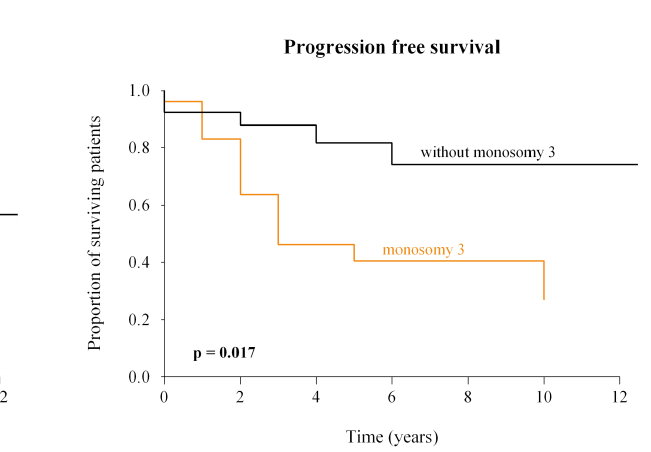
Fig. 1. Progression free survival (until presence of metastasis or death due to observed diagnosis of melanoma) by size of melanoma in diameter (P value of log-rank test is presented).